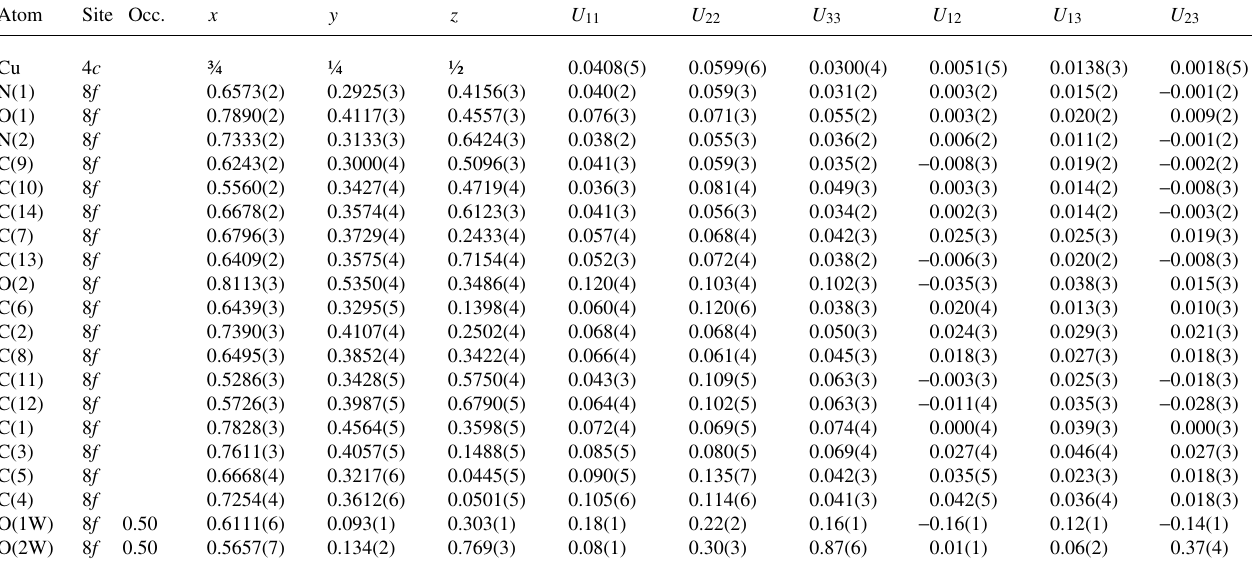
Table 3. Atomic coordinates and displacement parameters (in Å 2 )